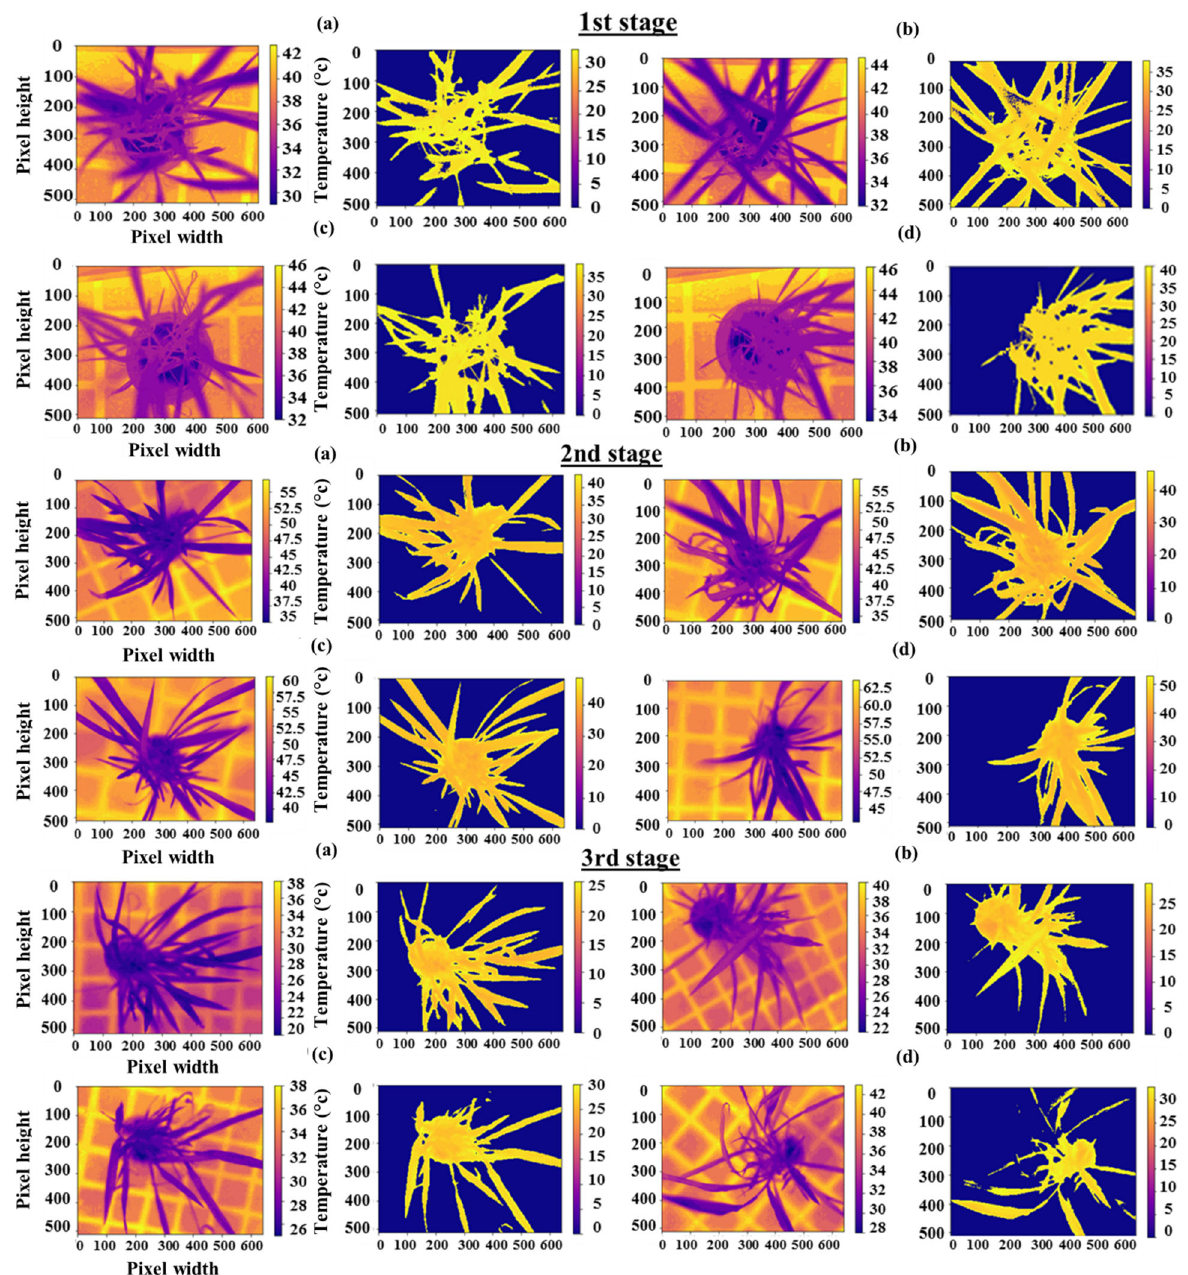
Figure 3. Raw thermal images of the rice and image segmentation with temperature distribution during four irrigation treatments: ( a ) 100%, ( b ) 80–70%, ( c ) 60–50%, and ( d ) 40–30% of field capacity at the three growth stages: tillering (1st stage), stem elongation (2nd stage), and panicle initiation (3rd stage).